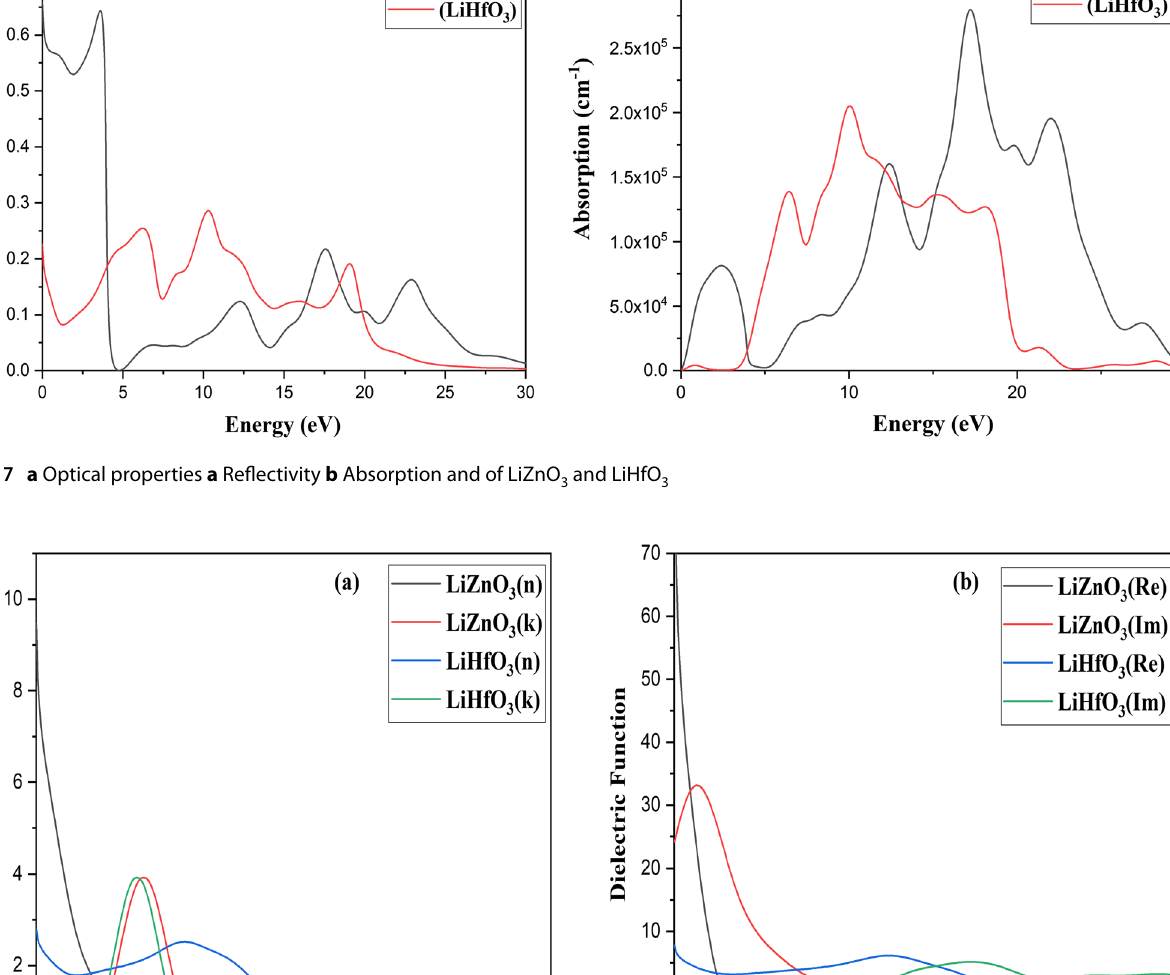
Fig. 8 Optical properties of LiZnO